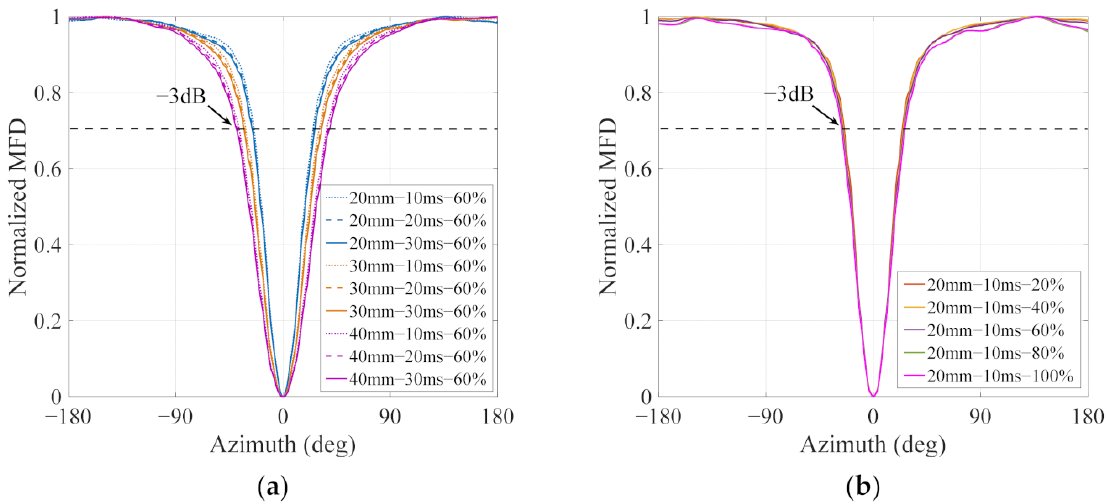
Figure 8. Comparison of different sampling times and PDs for different hole defects: ( a ) Comparison of different hole defects at different sampling times; ( b ) comparison of hole defects with different PDs.